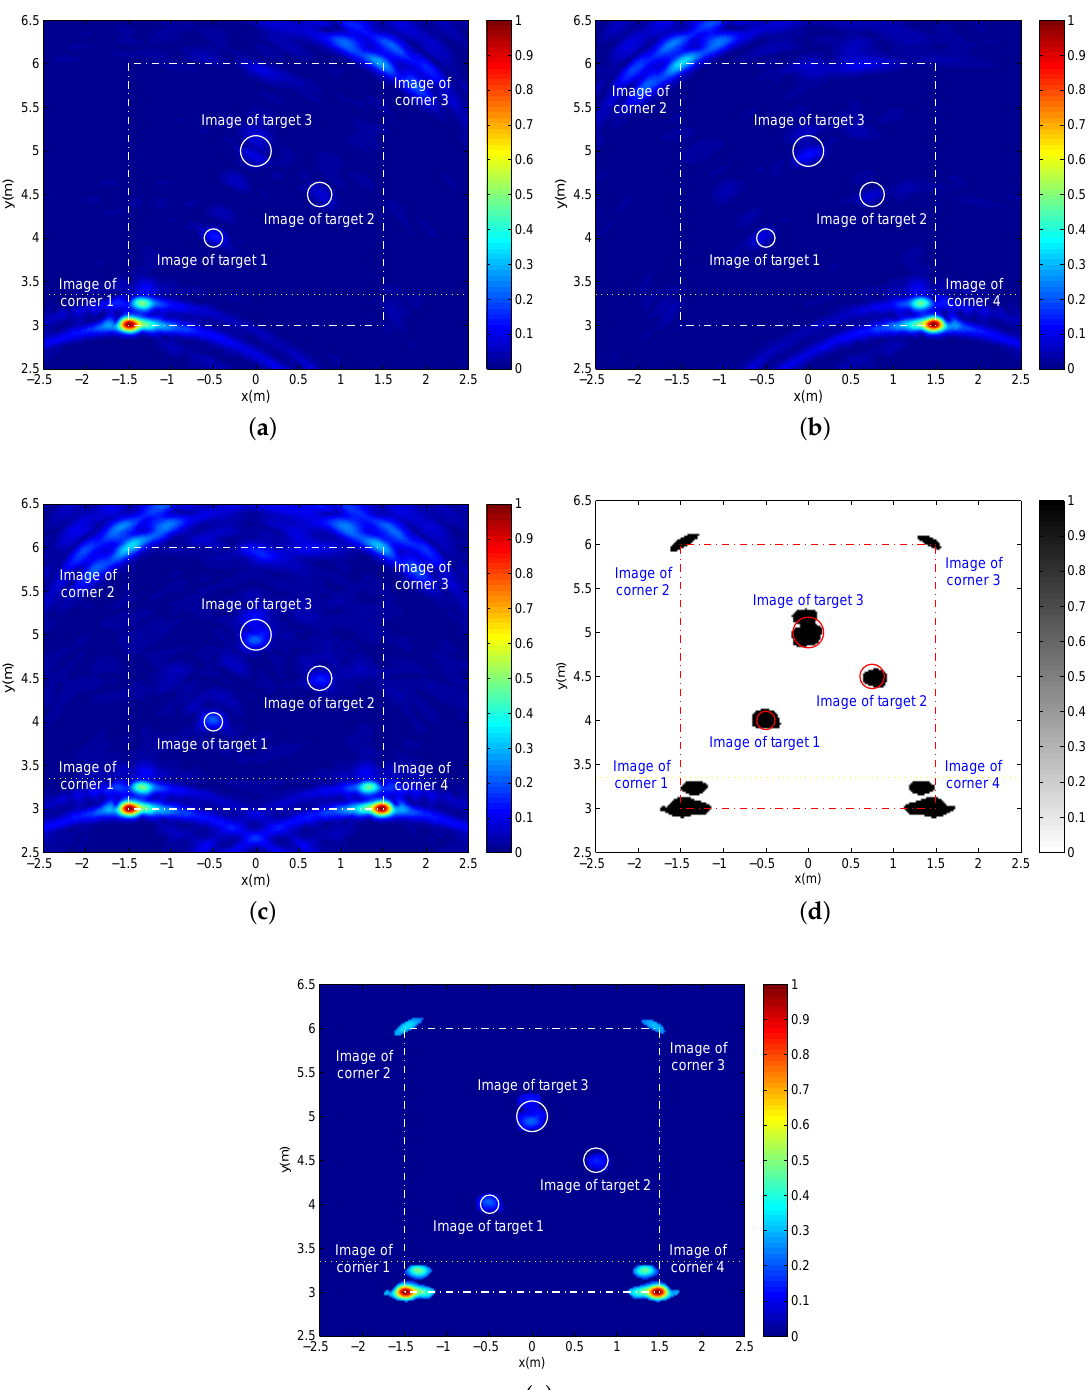
Figure 10. With the bandwidth of 770 MHz, ( a , b ) are two single-location images corresponding to Location A and Location B, respectively; ( c ) The panorama image after additive fusion; ( d ) The binary panorama image after 2D CA-CFAR with P fa = 0.0002, 61 × 61 reference window and 37 × 37 protection pixels; ( e ) The panorama image with the original pixel values after 2D CA-CFAR